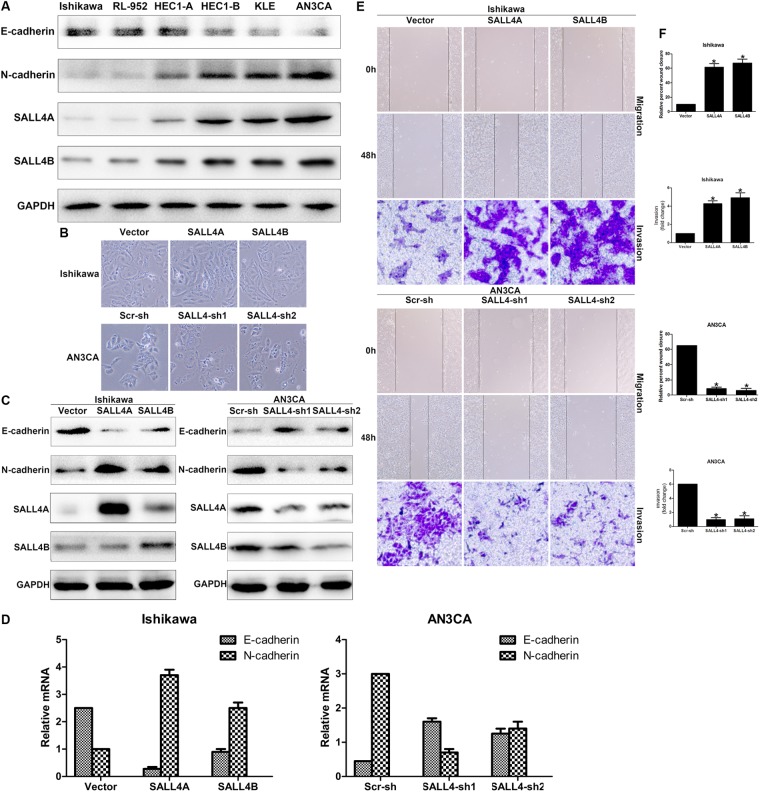
SALL4 induces the EMT and invasive phenotype in endometrial cancer cells.(A) N-cadherin, E-cadherin, SALL4A and SALL4B were assessed by western blotting in endometrial cancer cell lines: AN3CA, KLE, HEC1-B, HEC1-A, RL-952 and Ishikawa. (B) Cell morphology was examined in Ishikawa cells transfected with SALL4A or SALL4B expression vector and AN3CA cells transfected with SALL4-sh1 or SALL4-sh2. (C)(D) The protein and mRNA levels of E-cadherin and N-cadherin were analyzed in Ishikawa cells transfected with SALL4A or SALL4B expression vector and AN3CA cells transfected with SALL4-sh1 or SALL4-sh2. (E) Cell migration and invasion of Ishikawa or AN3CA were examined through wound healing assay and transwell invasion assay. (F) The degree of migration and invasion in Ishikawa and AN3CA cells was analyzed. *P<0.01.